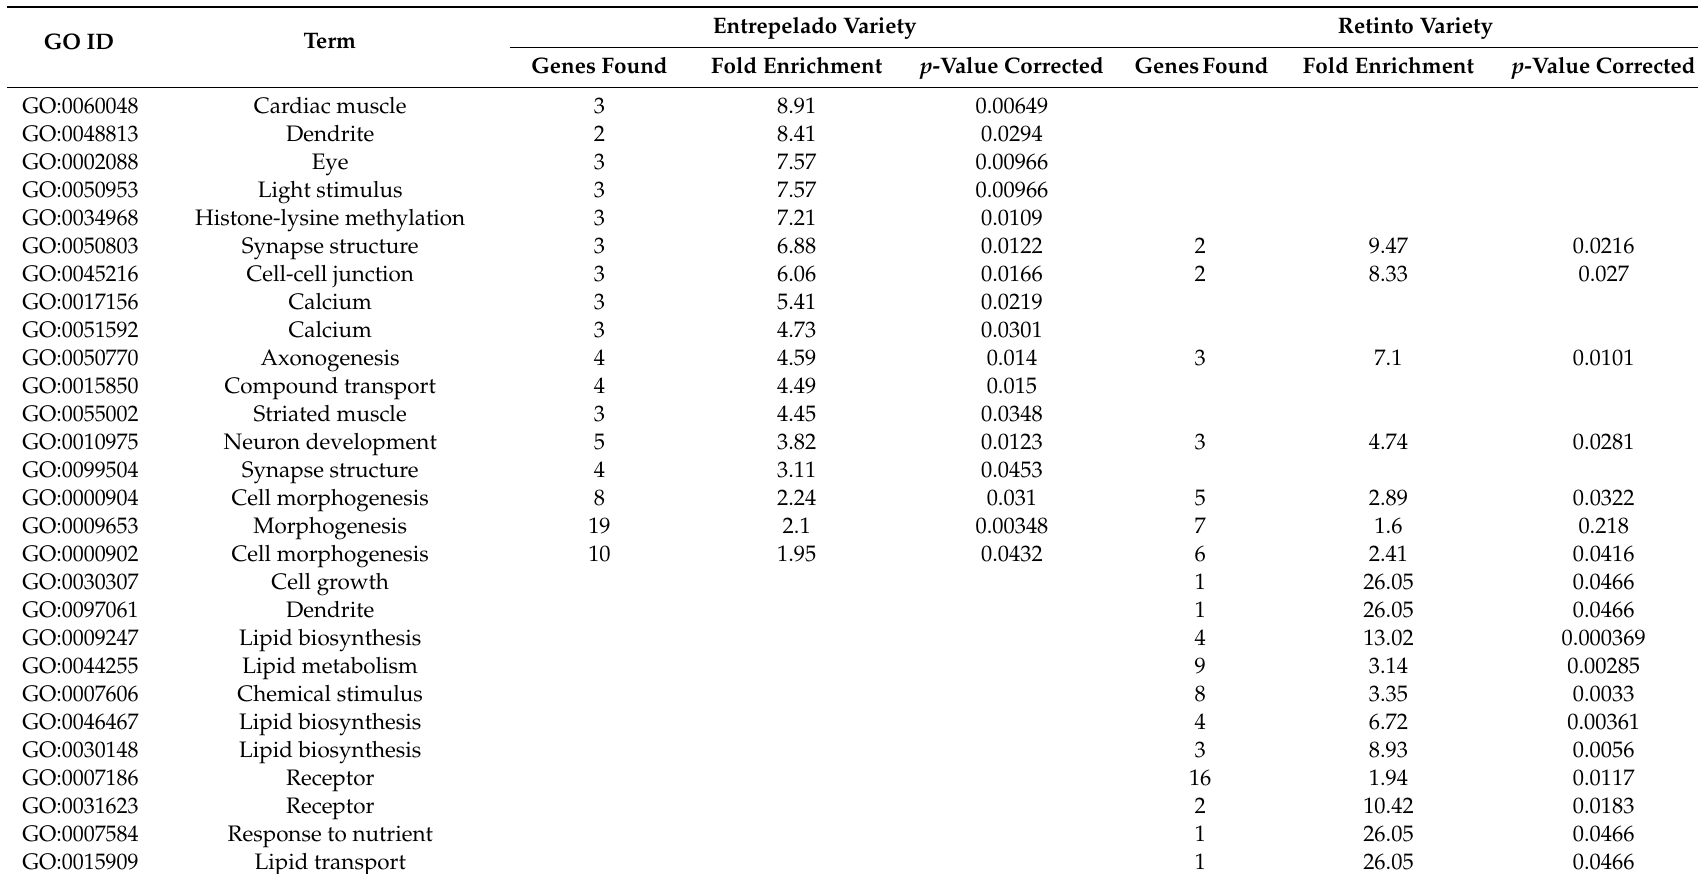
Table 4. The analysis of Gene Ontology (GO) biological process enrichment of the regions with maternal transmission ratio distortion loci (TRDLs) detected separately in both Entrepelado and Retinto